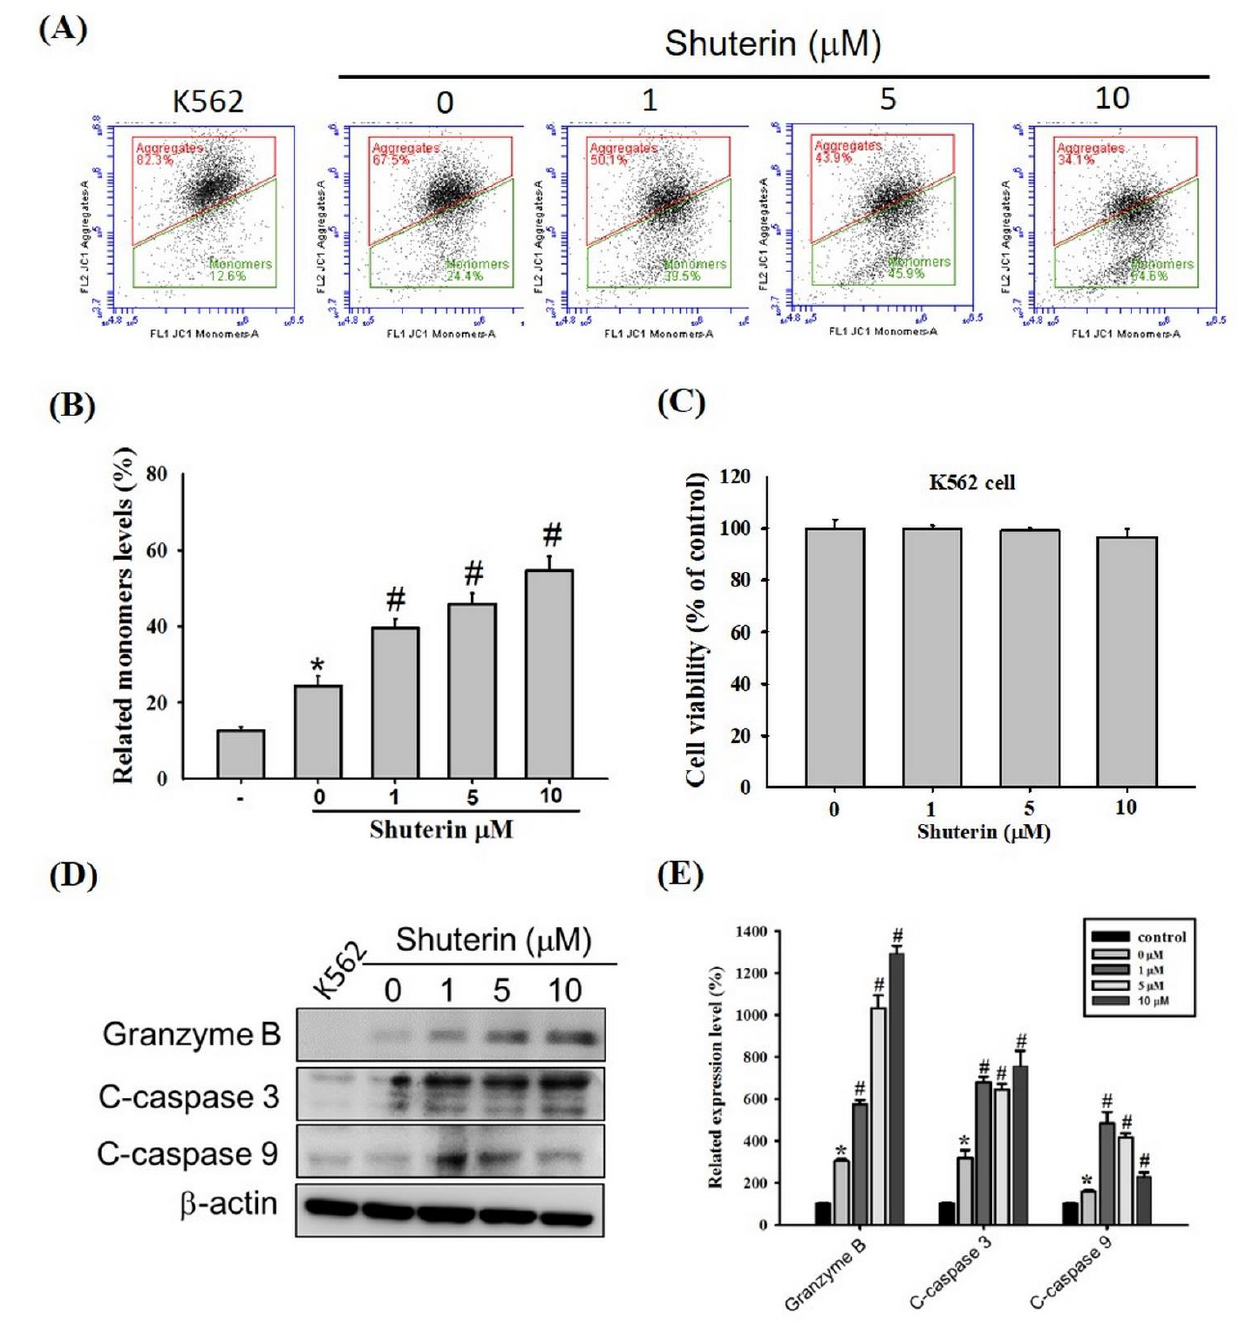
Figure 3. Shuterin-induced apoptosis in cocultured K562 cells. ( A ) The mitochondrial membrane potential of K562 cells was measured. ( B ) Quantitative data were analyzed using BD Accuri C6 soft- ware. ( C ) K562 cells were treated with shuterin (0–10 µ M) for 24 h. Cell viability was assessed using WST-8 assays. ( D ) K562 cells were cocultured with KHYG-1 cells at an effector:target ratio of 6:1 and then treated with shuterin (0–10 µ M) for 24 h. ( E ) Compared with control cells, statistically significant results were obtained in treated cells. * p < 0.05 V.S. control, # p < 0.05 V.S. cotreatment control.